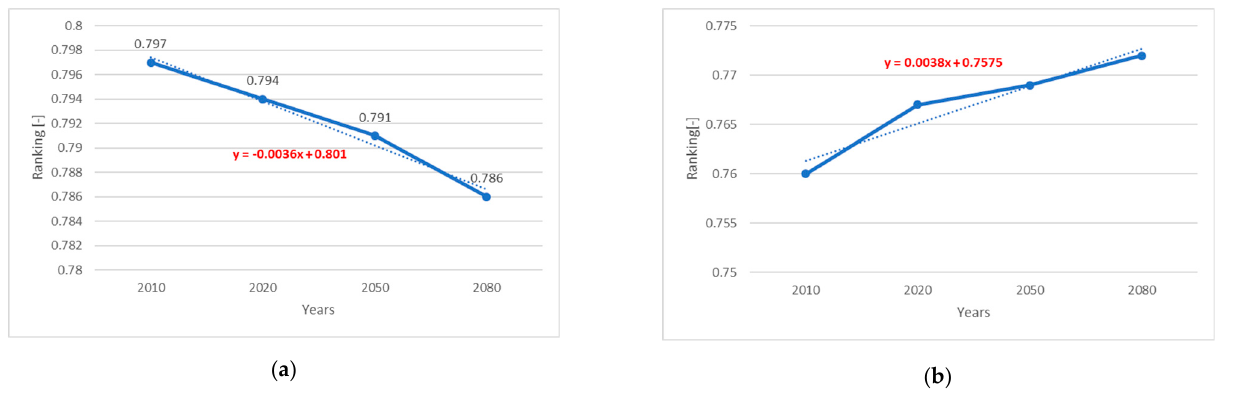
Figure 13. Variation of the ranking of the external wall alternatives in the predicted future; ( a ) the cavity wall with 4 cm of insulation; ( b ) the cavity wall with 6 cm of insulation.